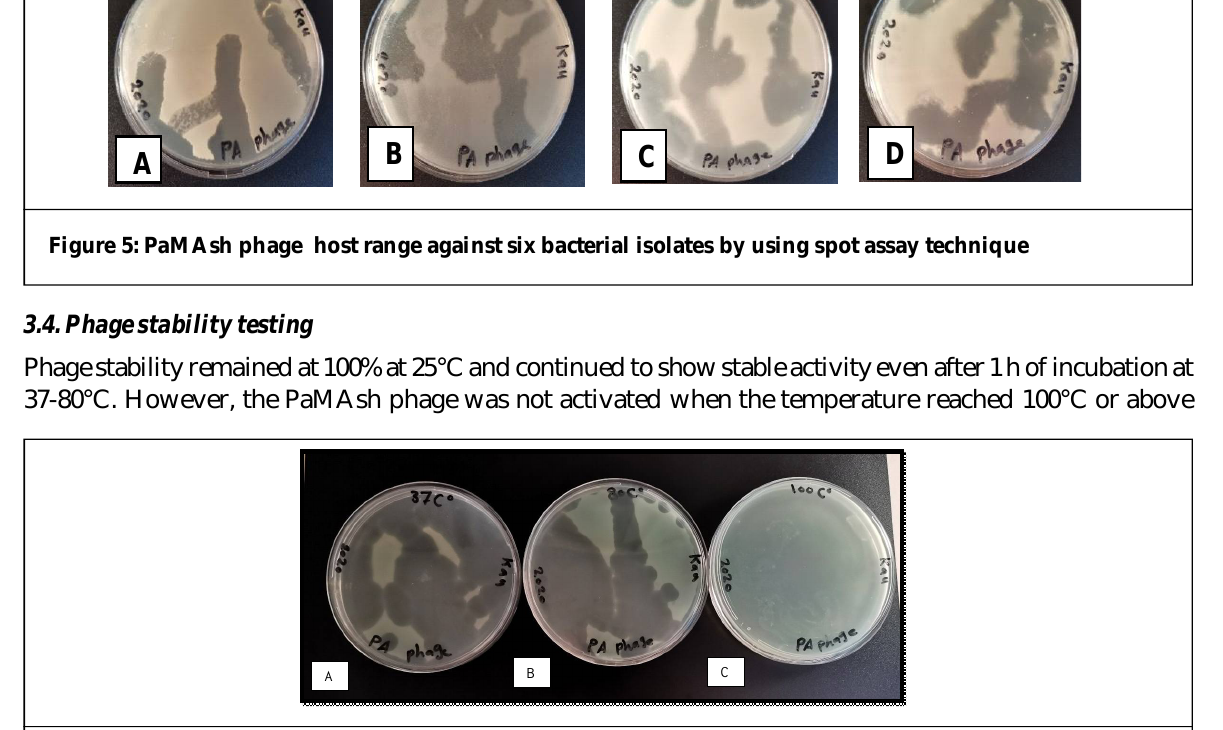
Figure 6: Spot test for PaMAsh phage at (A) 37°C, (B) 65°C and